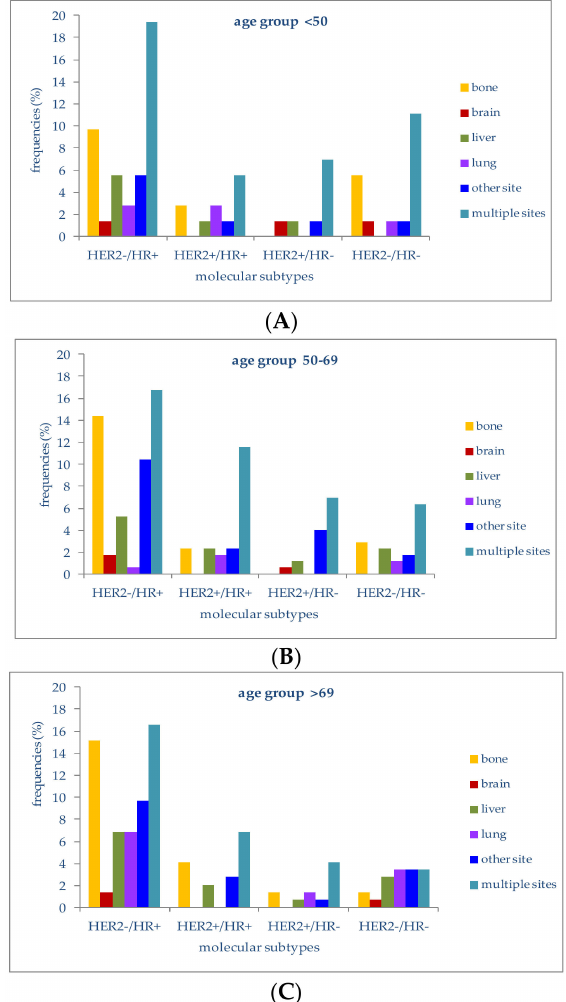
Figure 4. ( A ) Frequencies of metastatic sites in stage IV patients with different molecular subtypes in the age group <50 years; ( B ) Frequencies of metastatic sites in stage IV patients with different molecular subtypes in the age group 50–69 years; ( C ) Frequencies of metastatic sites in stage IV patients with different molecular subtypes in the age group >69